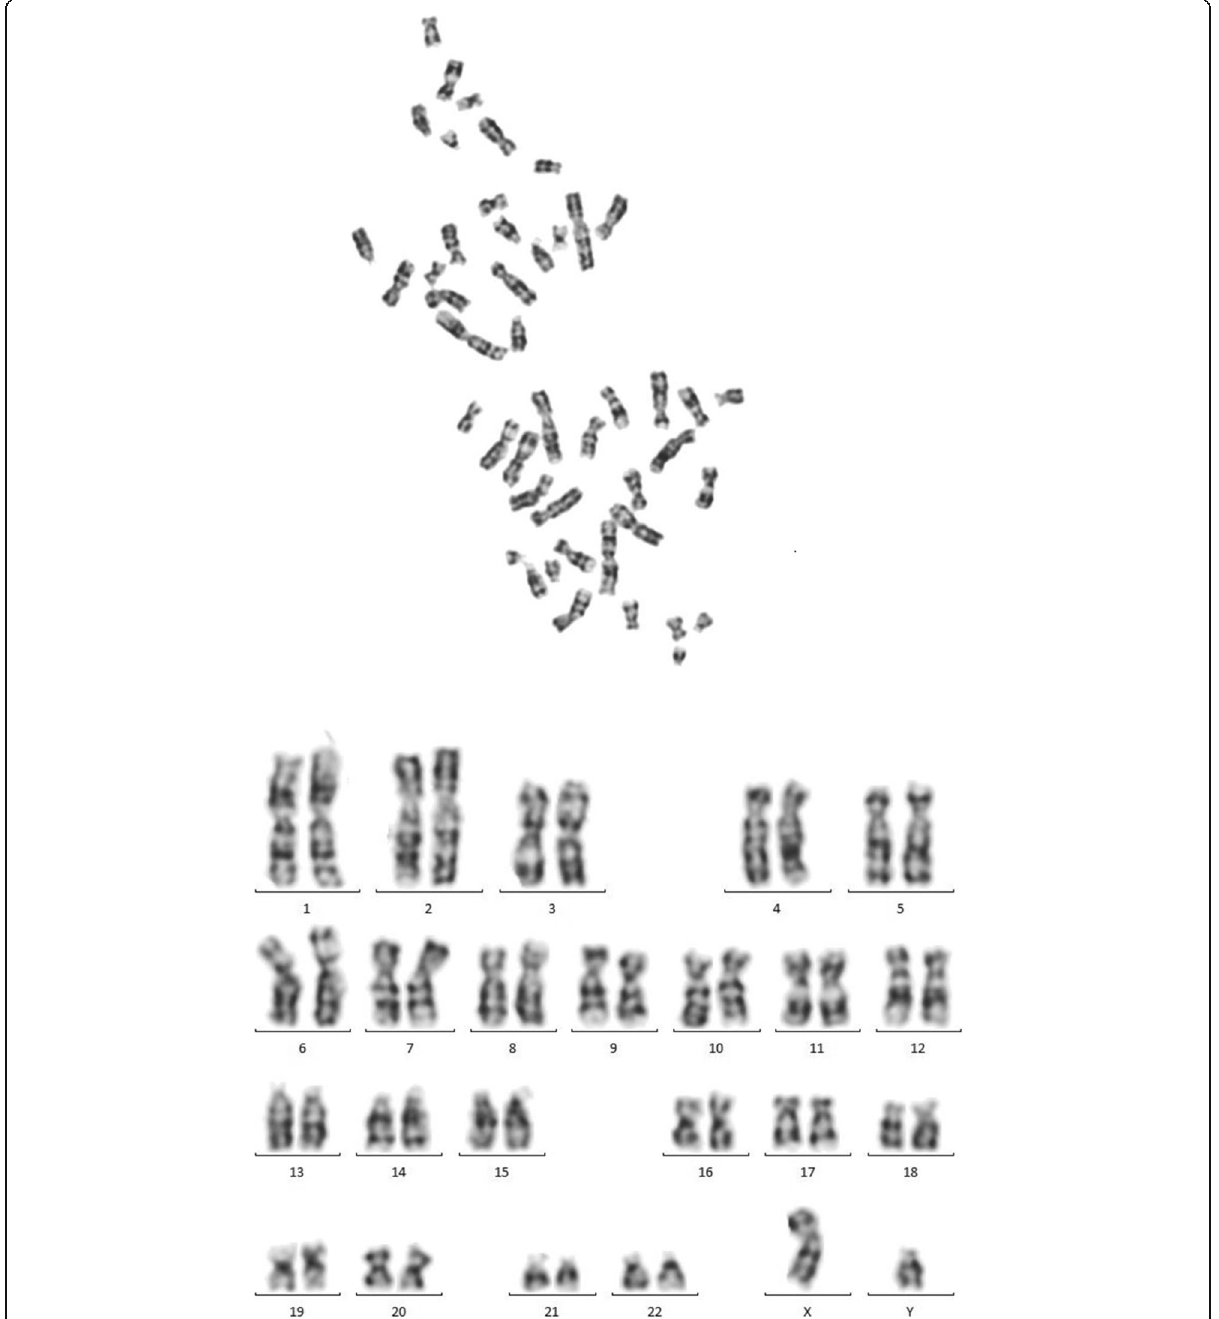
Fig. 2 Metaphase spread and karyotype of our patient showing normal 46,XY